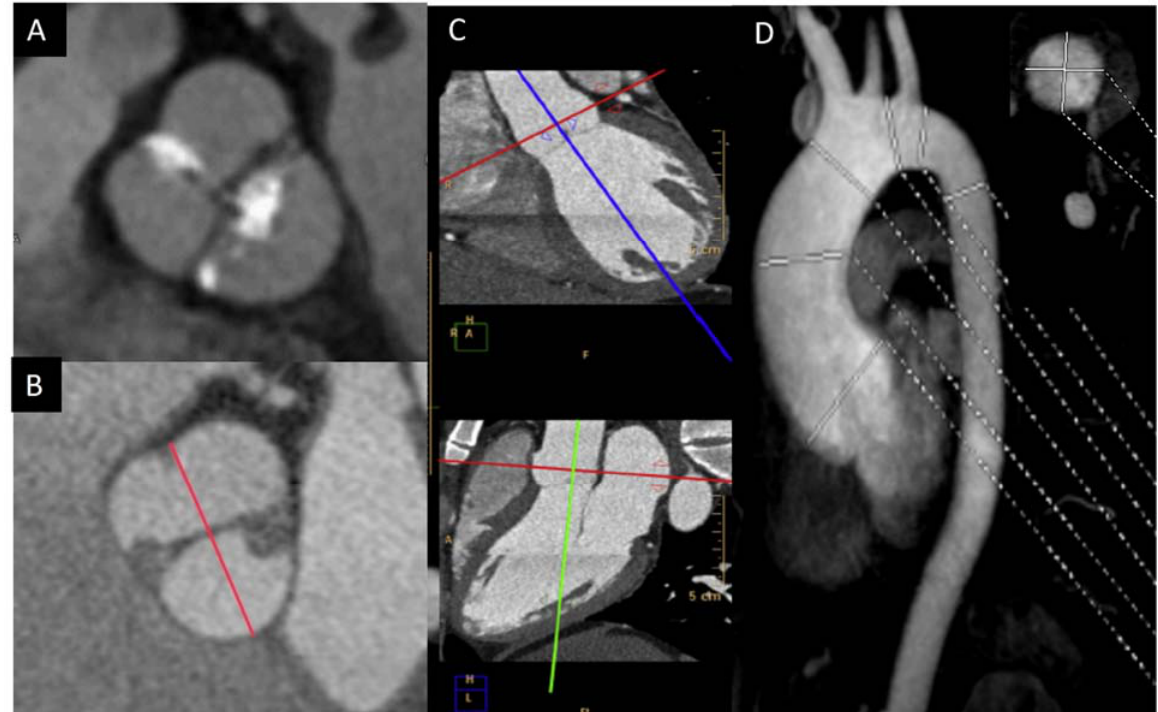
Figure 3. BAV by CT showing left − right fusion with raphe calcification and mild non ‐ coronary sigmoid edge calcification ( A ); CMR showing two ‐ sinus anteroposterior BAV ( B ); double obliquity image for measuring the maximum diameter of the aortic root by CT ( C ); thoracic aorta diameters by angio ‐ CMR sagittal projection; the right upper part shows the aortic root section obtained with double obliquity image ( D ).